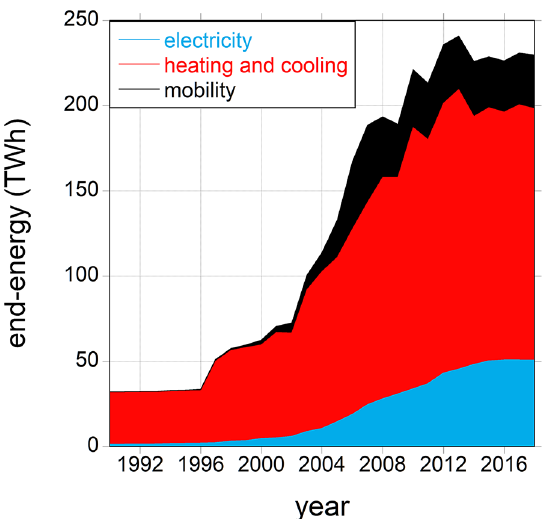
Fig. 7. – The use of biomass as end-energy is plotted vs. time for the three consumption sectors electricity production, heating and cooling, and mobility. Data are taken from the German ministry of economy and